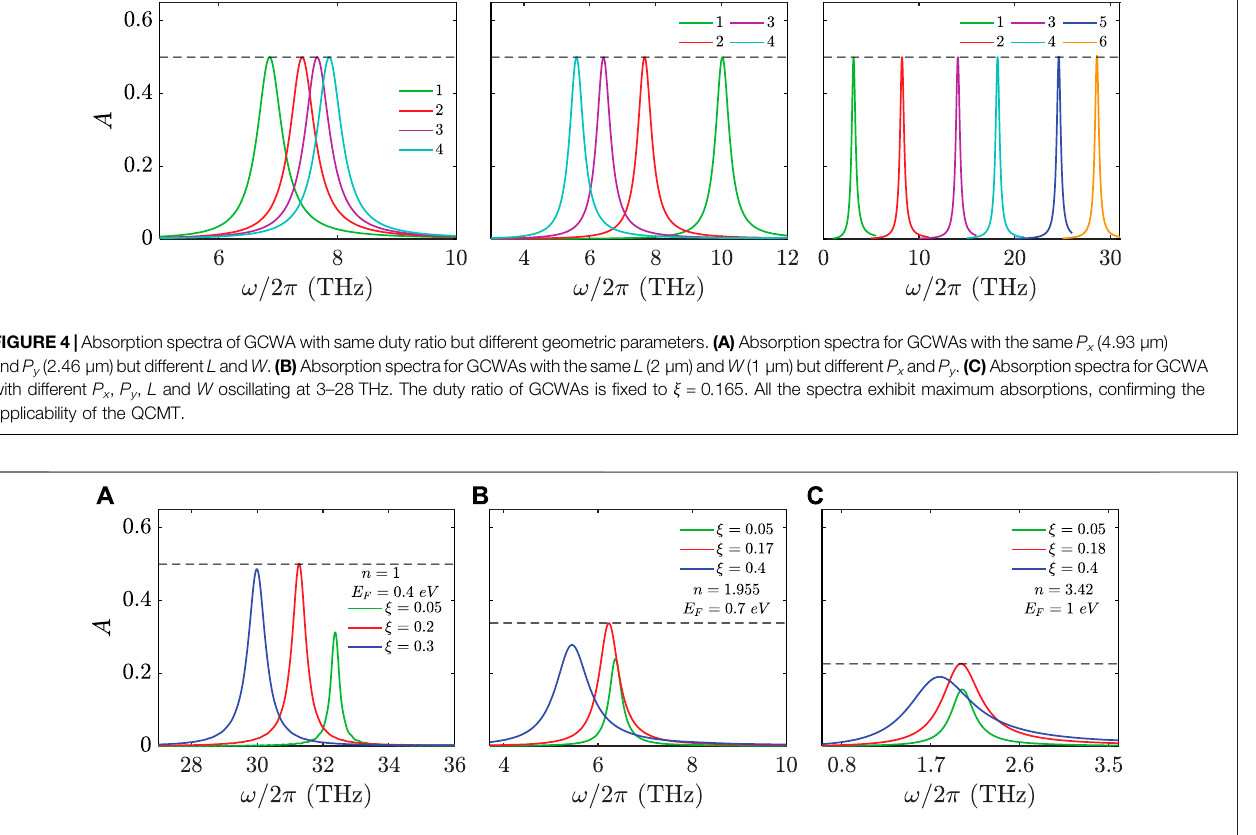
FIGURE 5 | Simulated absorption spectra of the GCWAs designed by the QCMT model. The geometrical parameter for each GCWA is: (A) L (cid:2) 0.088 μ m, W (cid:2) 0.044 μ m; (B) L (cid:2) 1.63 μ m, W (cid:2) 0.81 μ m; (C) L (cid:2) 7.92 μ m, W (cid:2) 3.96 μ m. The GCWAs corresponding to (A – C) are respectively suspended in the air (A) and supported onto SiO 2 (B) and silicon (C) substrates. For better demonstration, for each array the absorption spectra corresponding to duty ratios that are not associated with the optimum absorption are included. Black dashed lines shown in (A – C) indicate the maximum absorption of each array.